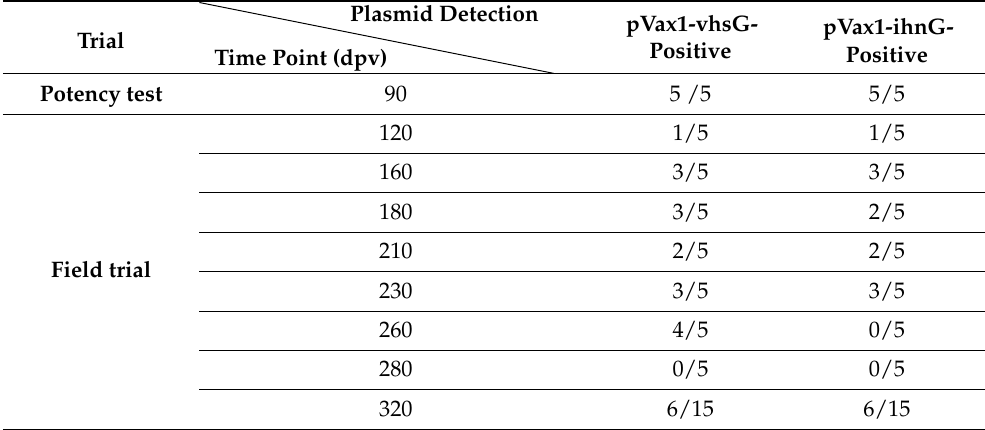
Table 8. Persistence of plasmids in epaxial muscle of rainbow trout collected at different days post-vaccination (dpv) during the field